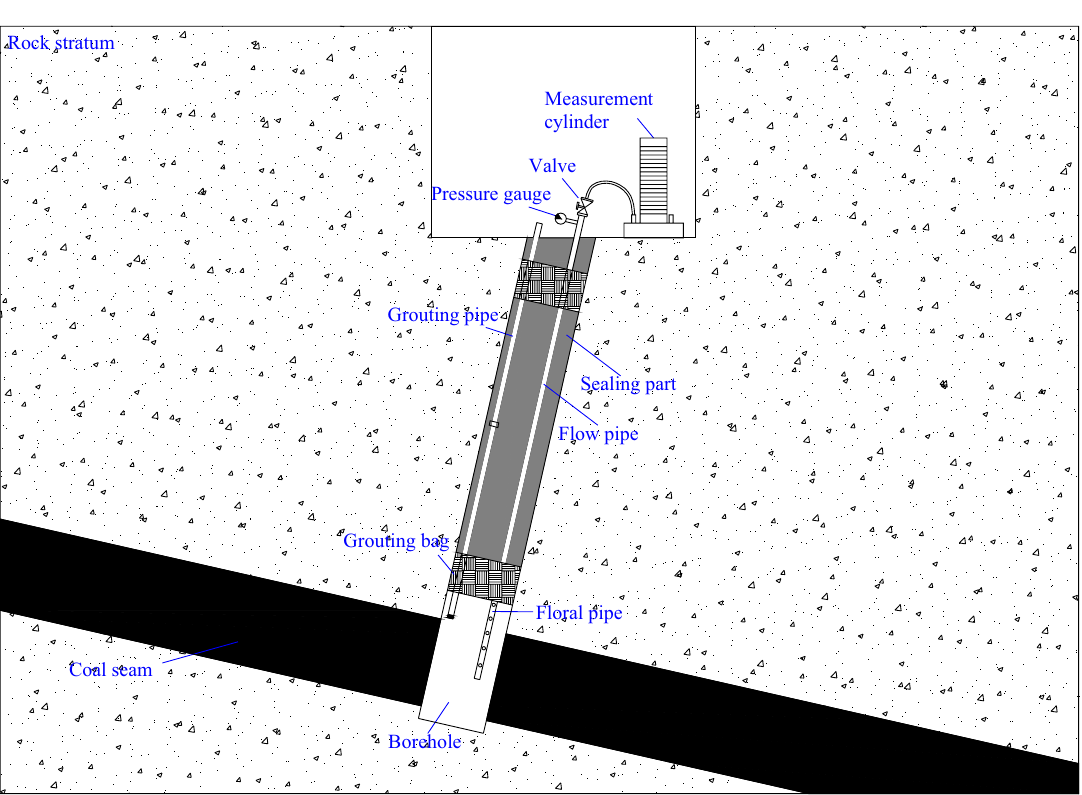
Figure 3. Diagram of field measurement of the gas pressure and the permeability